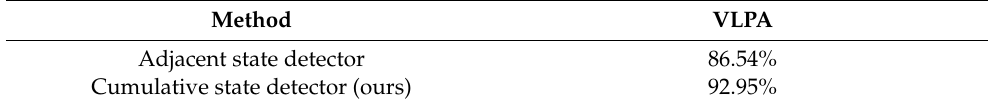
Table 7. The VLPA of different state detectors.